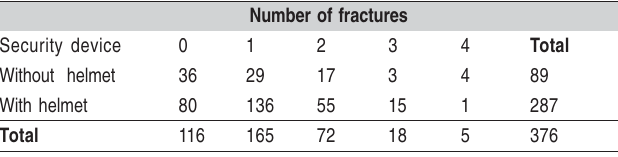
Table 2. Distribution of maxillofacial fractures